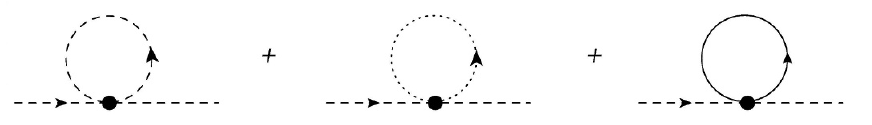
Figure 3. The (cid:3) d divergent corrections to the (cid:30) 1 propagator.